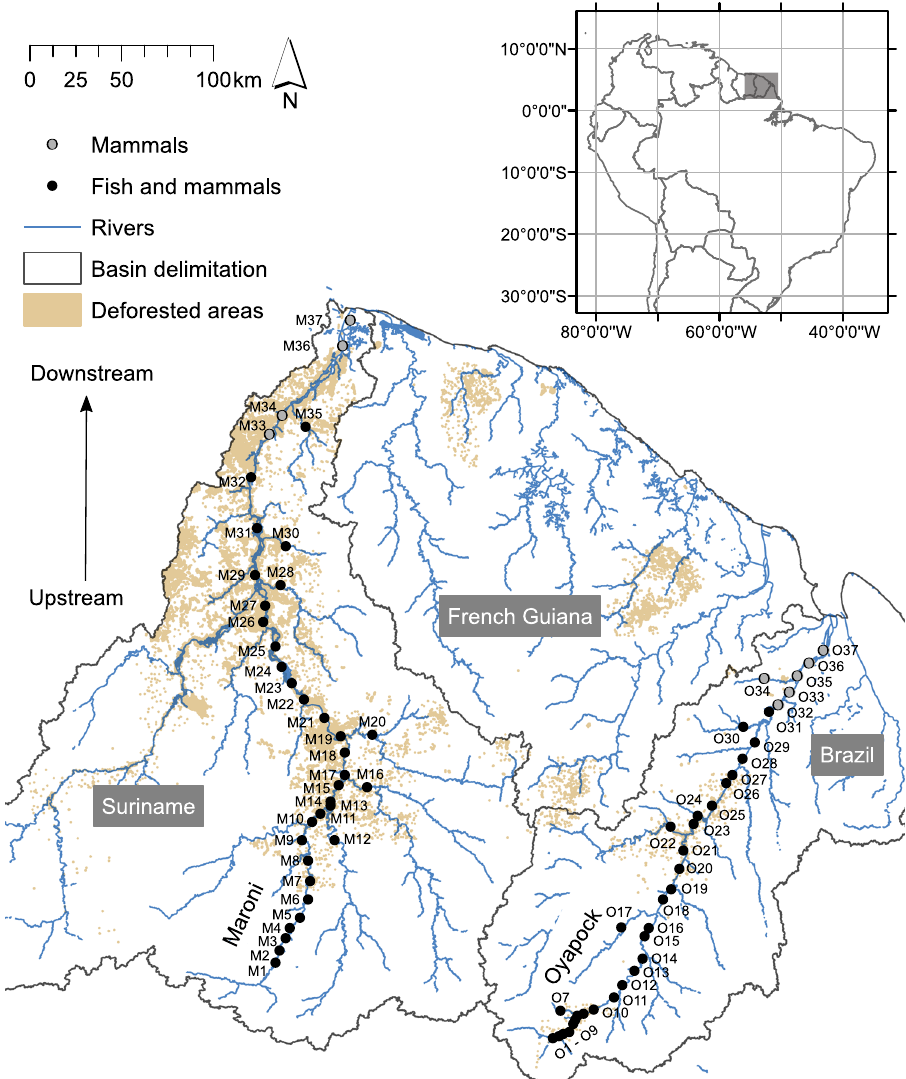
Fig. 2 Map of the study area and biodiversity sampling sites. The 64 fi sh sampling sites are shown in black. Mammals were sampled at all 74 sites. The highlighted grey area in the inset at the upper right indicates the study area in South